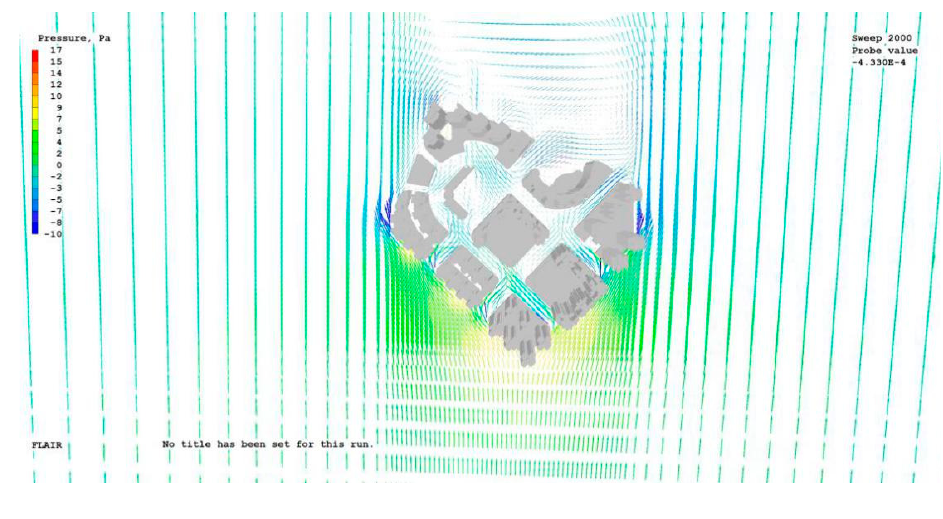
Figure A2. Summer vector diagram, summer wind field pressure vector diagram, and summer vector diagram of wind field flow velocity at 10 m height.